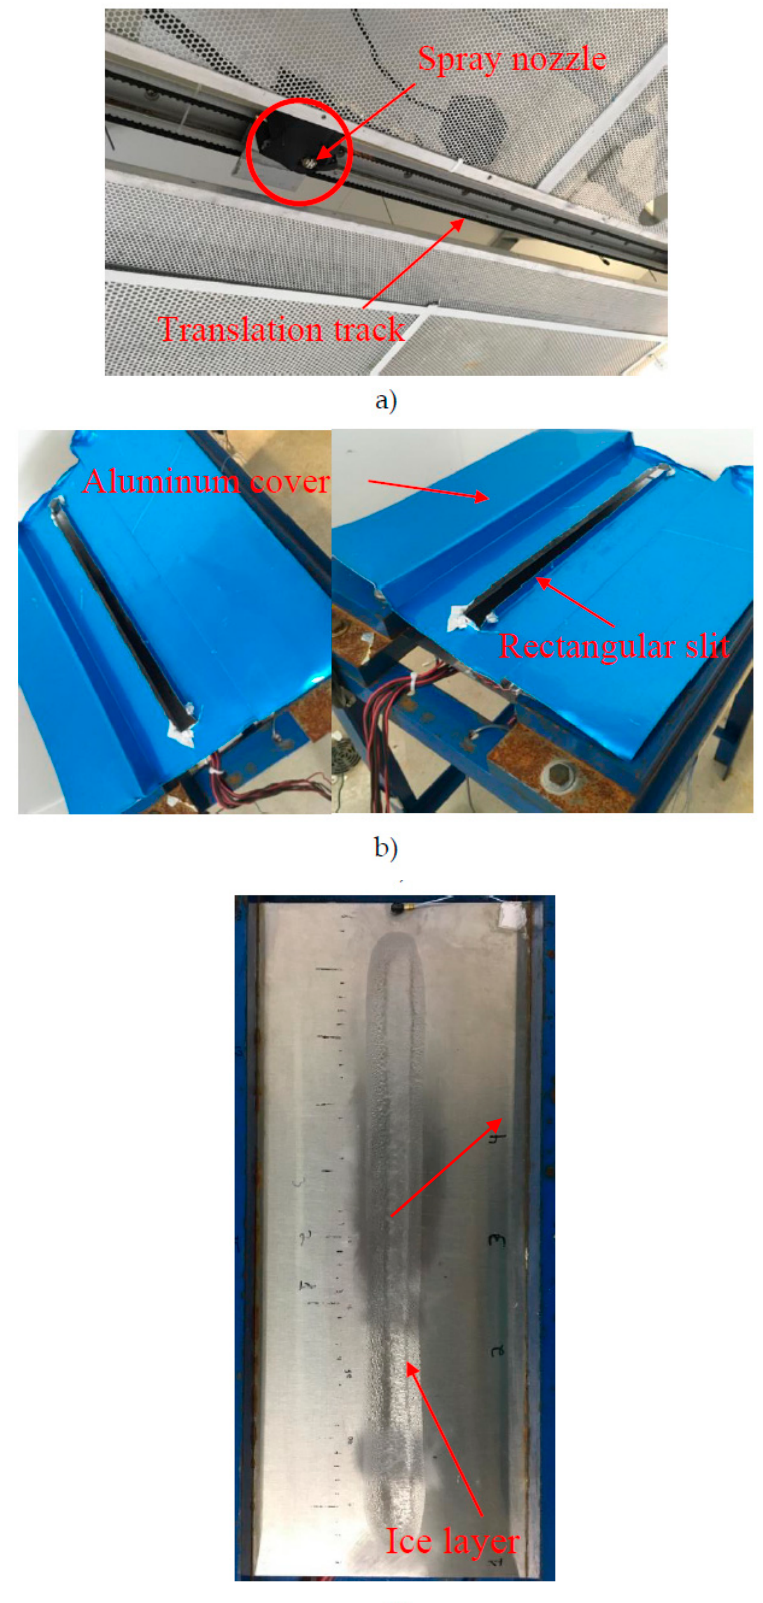
Figure 2. ( a ) Spray nozzle installed on translation track ( b ) Aluminum cover for ice accumulation and ( c ) Ice layer accumulated on the flat plate setup.